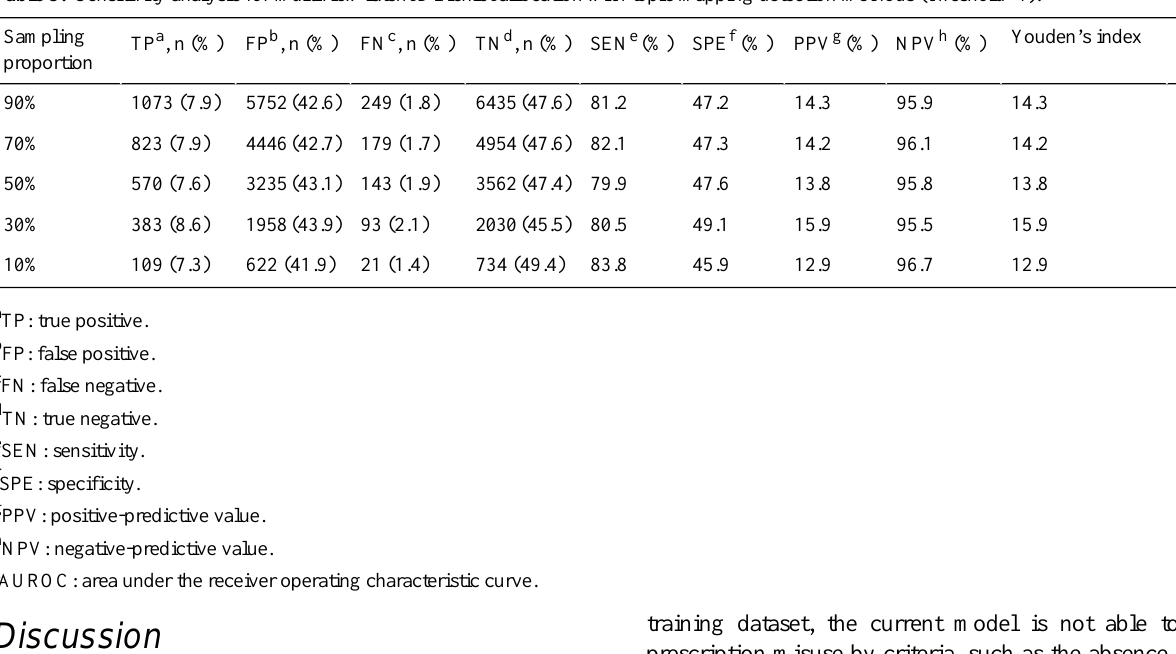
Table 3. Sensitivity analysis for multiview latent Dirichlet allocation with topic mapping detection methods